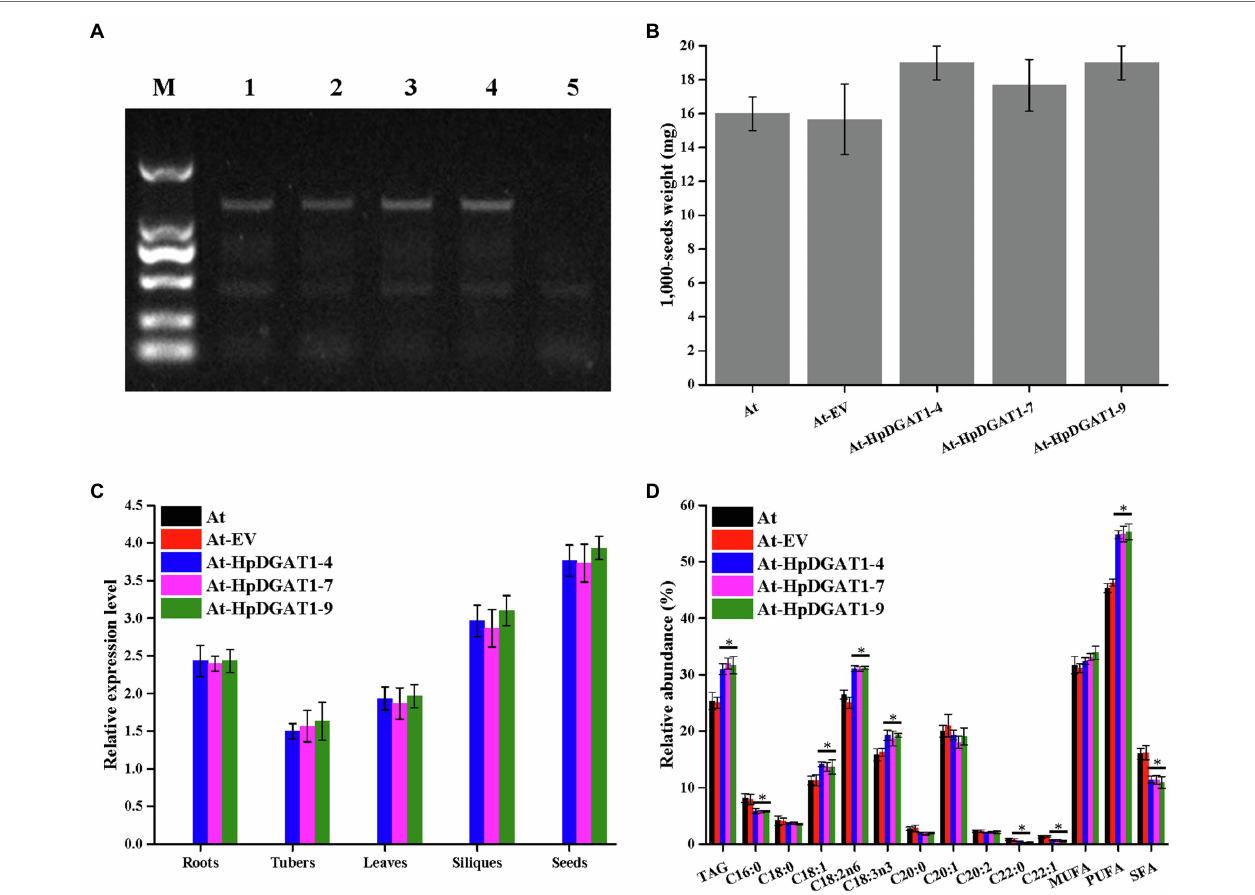
FIGURE 4 | Genetic engineering of HpDGAT 1 in Arabidopsis thaliana . (A) Genomic detection of HpDGAT1 in A. thaliana . 1: pCAMBIA1303- HpDGAT1 ; 2: At- HpDGAT1 -4; 3: At- HpDGAT1 -7; and 4: At- HpDGAT1 -9; 5: At-EV. (B) Average 1,000-seed weight (expressed as milligrams of weight/1,000 seeds) of transgenic Arabidopsis T2 seeds. (C) The transcriptional expression levels of HpDGAT1 in A. thaliana . The gene expression levels were normalized to the endogenous AtACTIN gene. (D) TAG content and relative abundance of fatty acids in A. thaliana transformed with